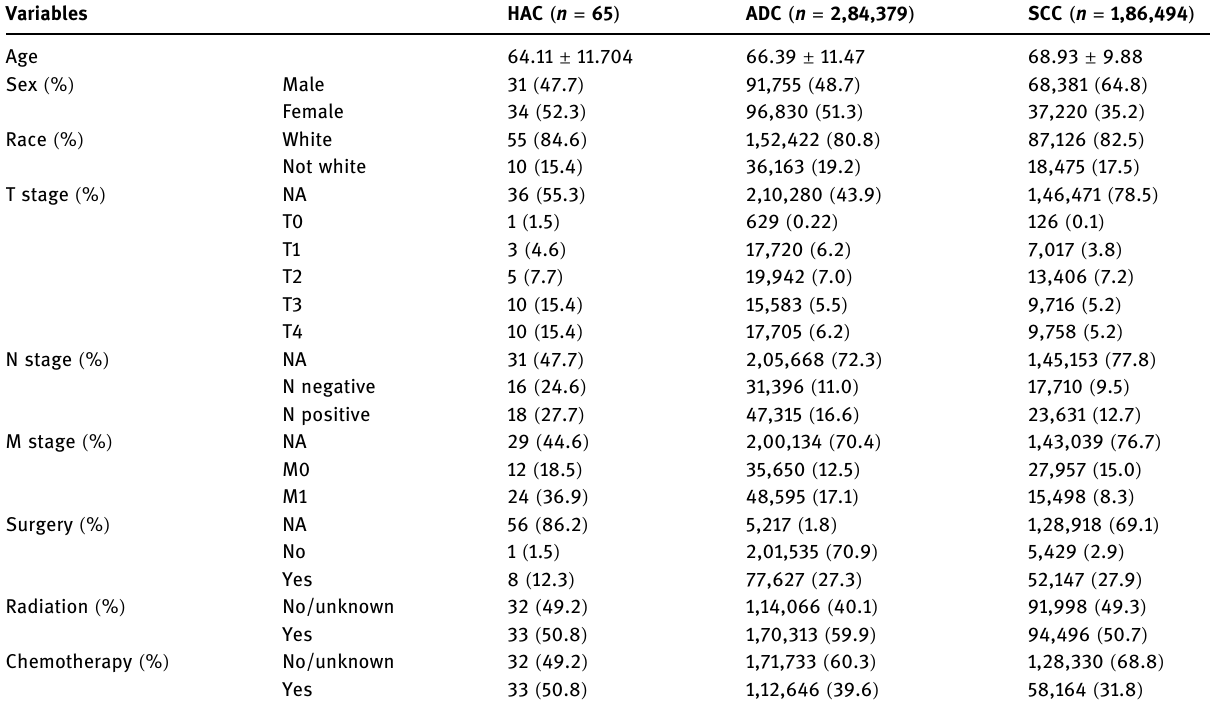
Table 1: Comparison between HAC, ADC, and